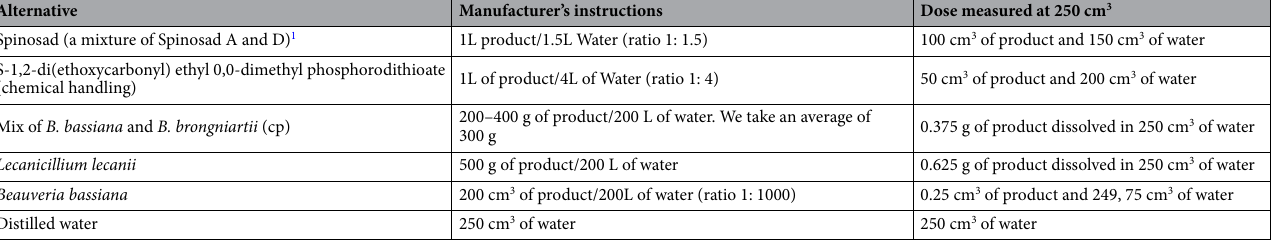
Table 3. Doses of management treatments. Source : 20–23